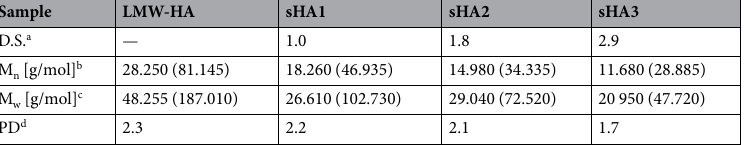
Table 2. Characteristics of synthesized polymeric HA derivatives. a D.S.: degree of sulfation, average number of sulfate groups per disaccharide unit of GAG. b M n : number-average molecular weight, determined by Laser Light Scattering (LLS) detection and Refraction (RI) detection (in brackets). c M w : weight-average molecular weight, determined by LLS detection and RI detection (in brackets). d PD: polydispersity index based on the values calculated from RI